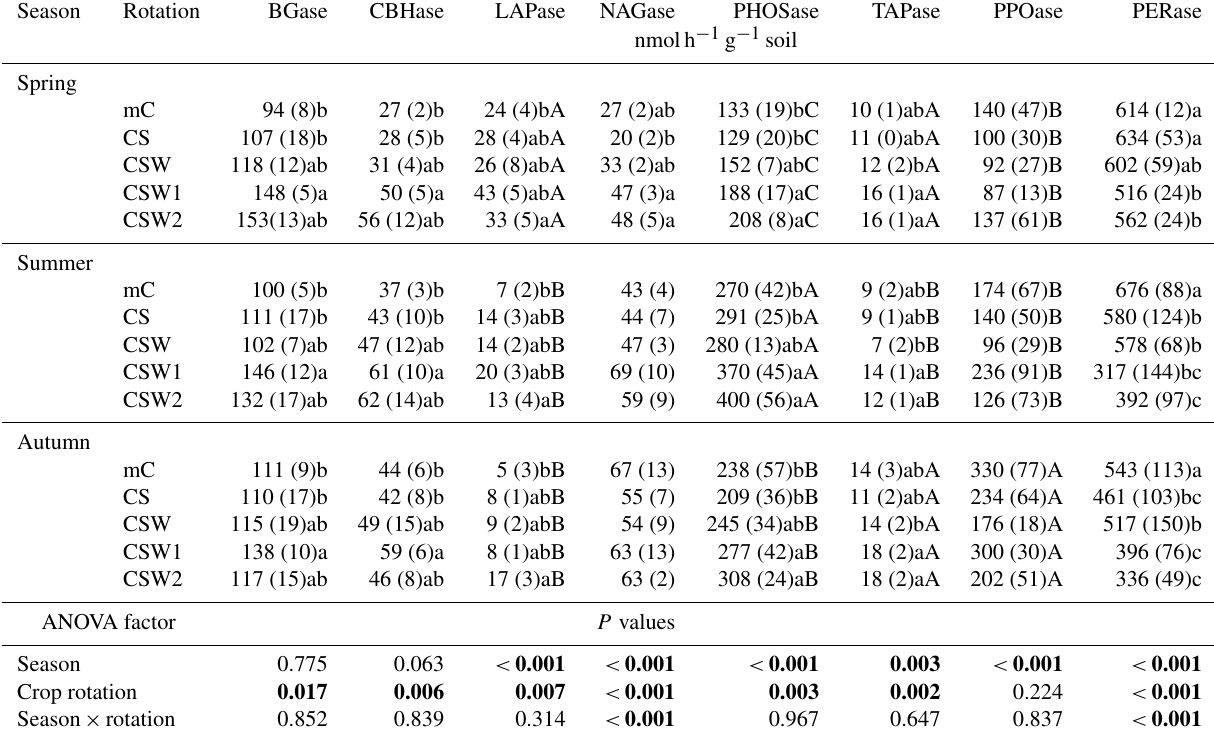
Crop rotation Season × rotation Note: see Table 1 for crop rotation abbreviations. Means ( n = 4) are shown with standard errors in parentheses. Significant comparisons ( P values in bold) are shown among rotations (lowercase) and season (capital) with